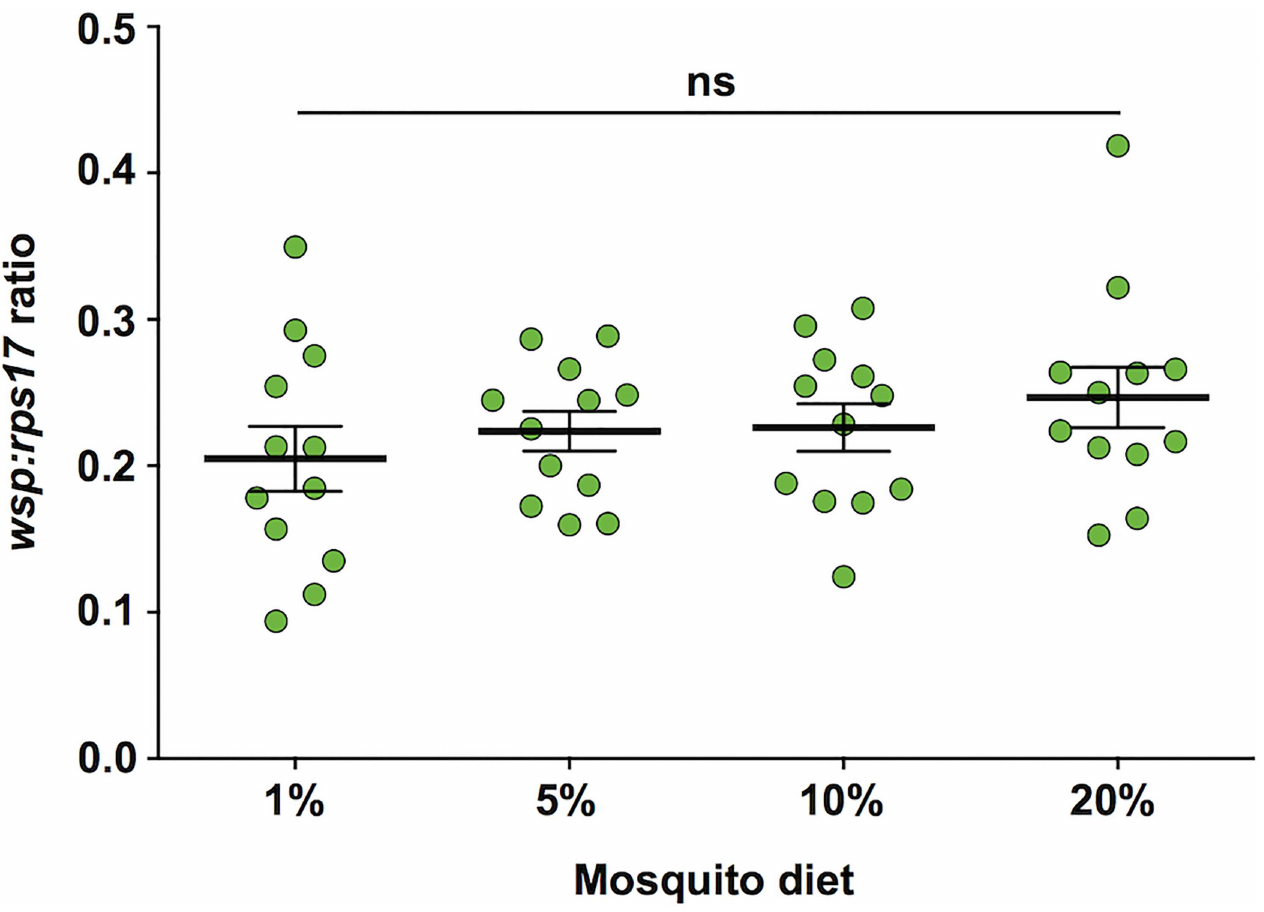
Fig 3. Wolbachia levels in w Mel-infected Ae . aegypti fed on different carbohydrate regimes. Expression levels of Wolbachia surface protein ( wsp ) were quantifiedrelativeto the mosquito rps17 genefor 12 pairs of female mosquitoesfrom each diet using RT-qPCR. Each circle represents one pair of mosquitoes. Solid black lines represent mean expression ( ± s.e.m.). P values: ns >